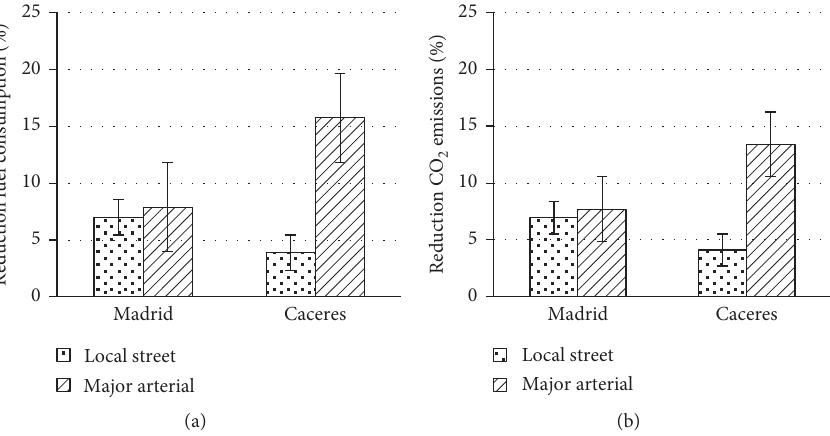
Figure 8: Impact of eco-driving in fuel consumption and CO